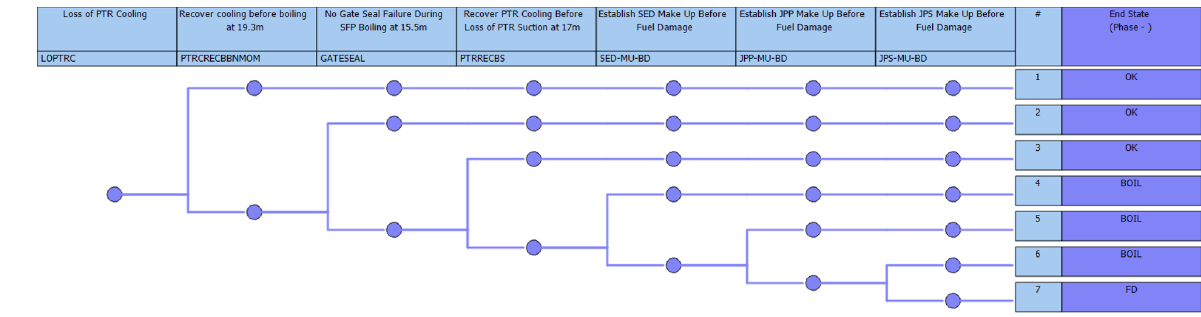
Figure 1. Loss of SFP Cooling Event Tree.